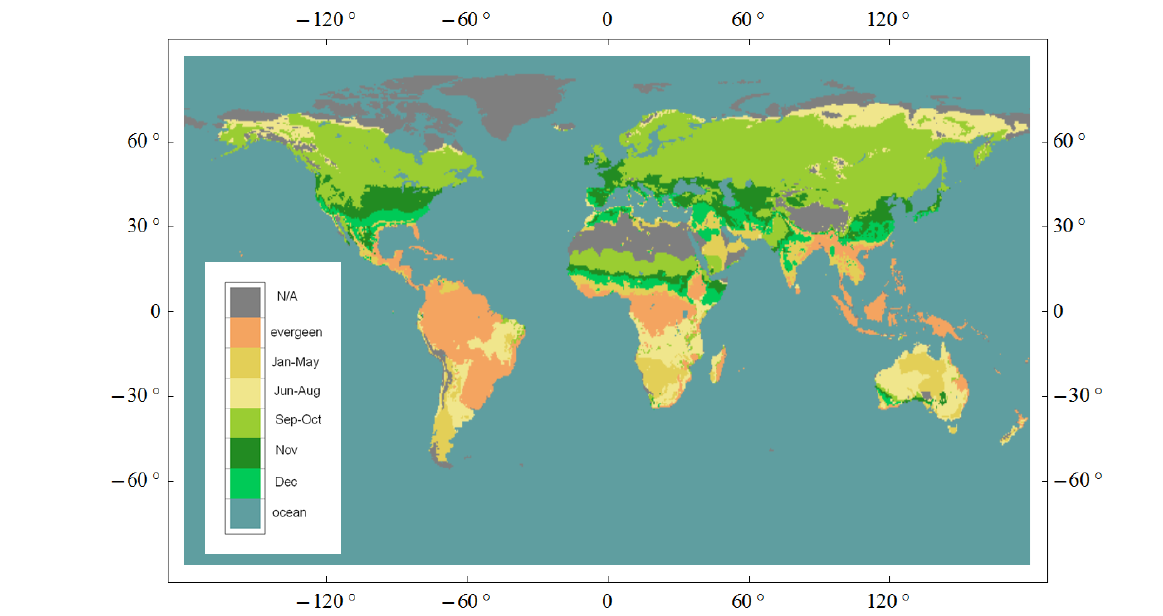
Figure 5. The month at which deciduous trees supposedly shed leaves due to the end of growing season.